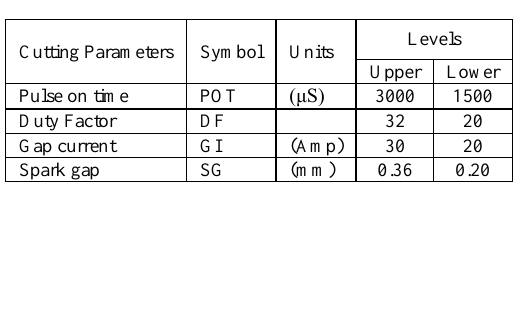
Table 1. Control parameters and